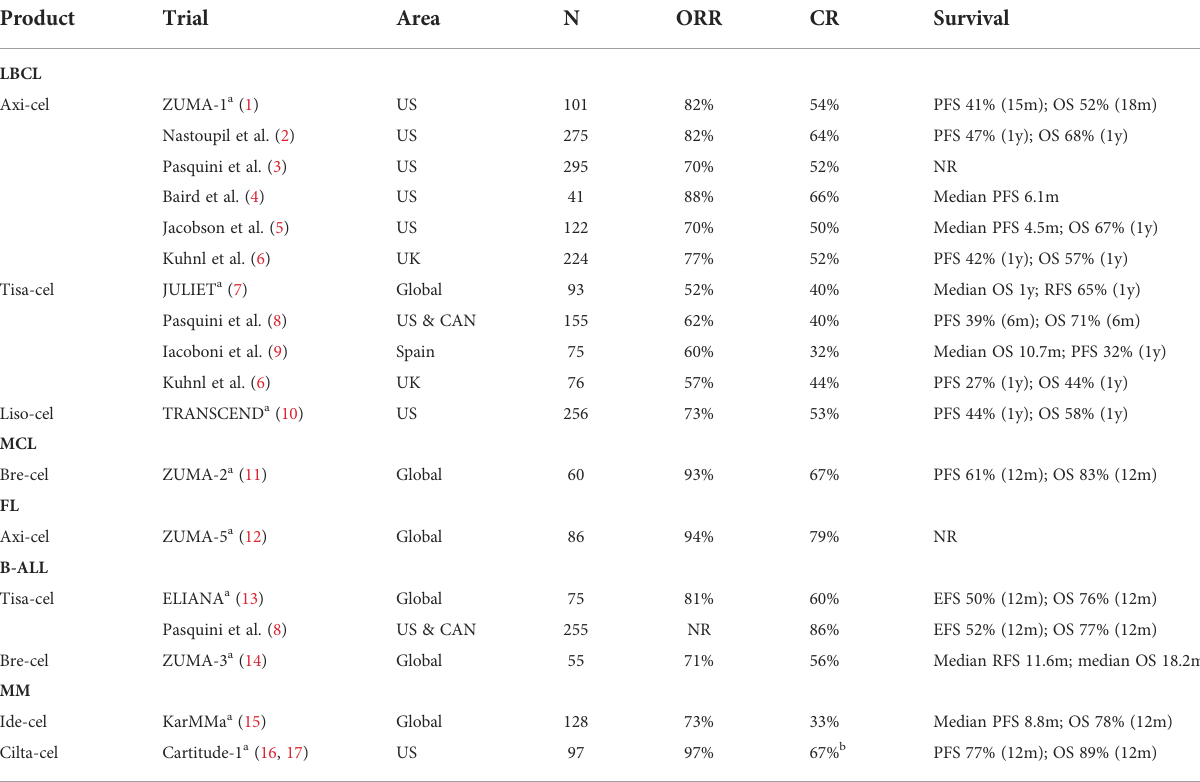
TABLE 1 Pivotal trials and real-world data of FDA approved CAR T cell products.